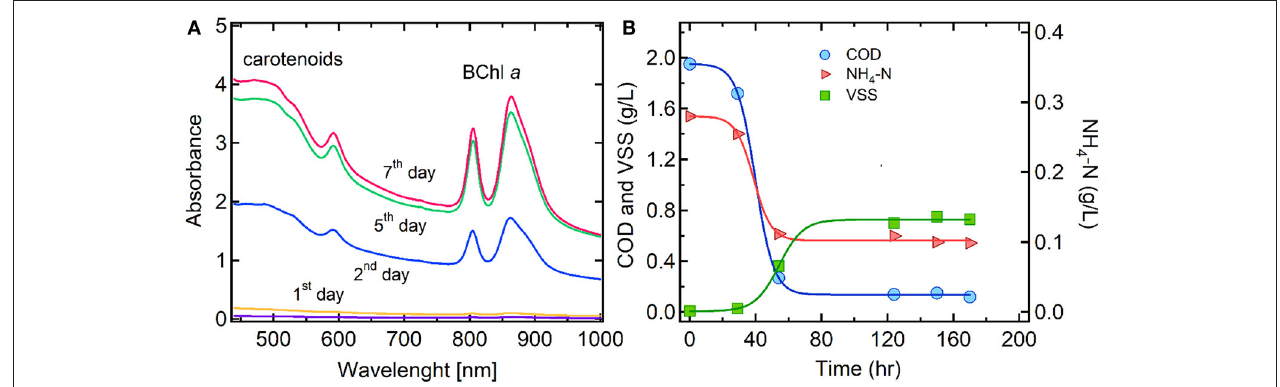
FIGURE 2 | Performance of PPB culture during a weekly operating cycle: (A) BChl a and carotenoids absorption spectra due to PPB growth, (B) COD and NH 4 -N assimilation and PPB concentration as VSS.